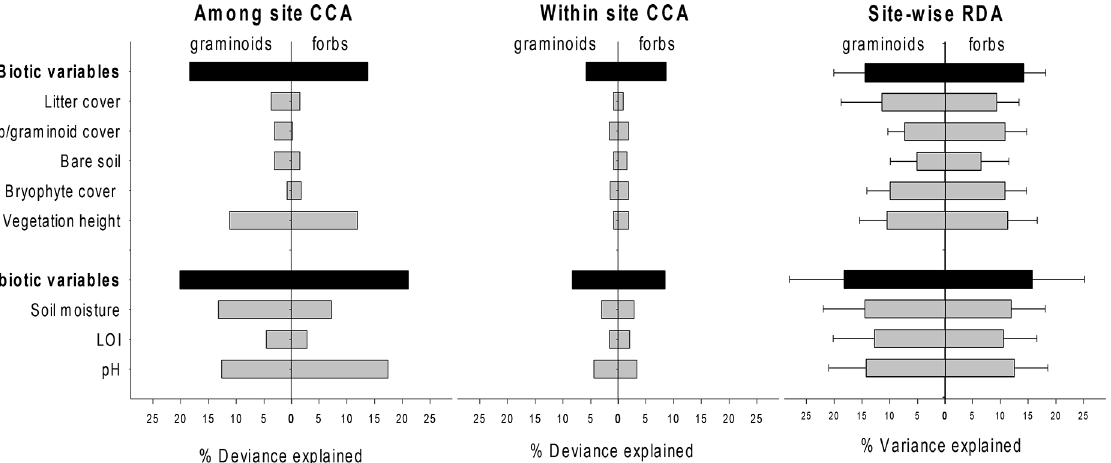
Fig 3. Variation explained at broad and fine geographical scales. Compositional variation in graminoid and forb species (% of total deviance [CCA] or variation [RDA]) explained by abiotic and biotic environmental variables, grouped and separately, at the a) regional/among site scale and b) local/within site scale when all sites are part of the same canonical correspondence analysis (CCA). Part c) shows parallel results for separate site-wise redundancy analyses (RDA) analyses for each of eleven grassland sites in southern Norway. LOI refers to Loss-On-Ignition, a measure of soil organic